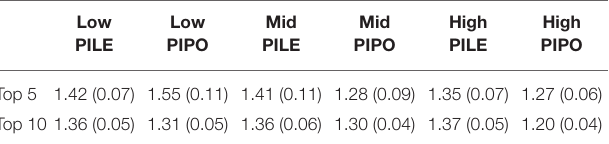
TABLE 3 | Wet:Dry ratios of ring-width index values by species and elevation for the top five and top 10 wettest and driest years. Low